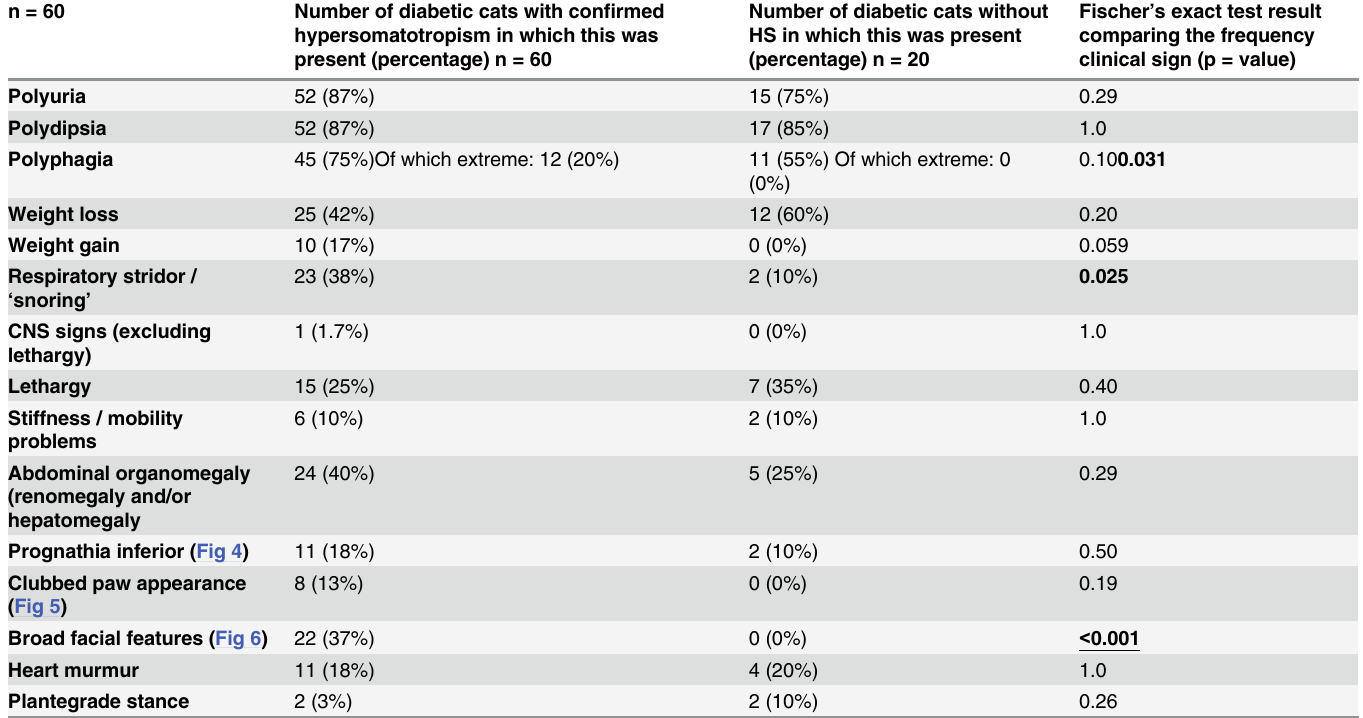
Table 2. Table depicting the clinical signs displayed by the diabetic cats in the group with confirmed HS, compared to a group of cats newly diag- nosed with primary diabetes mellitus